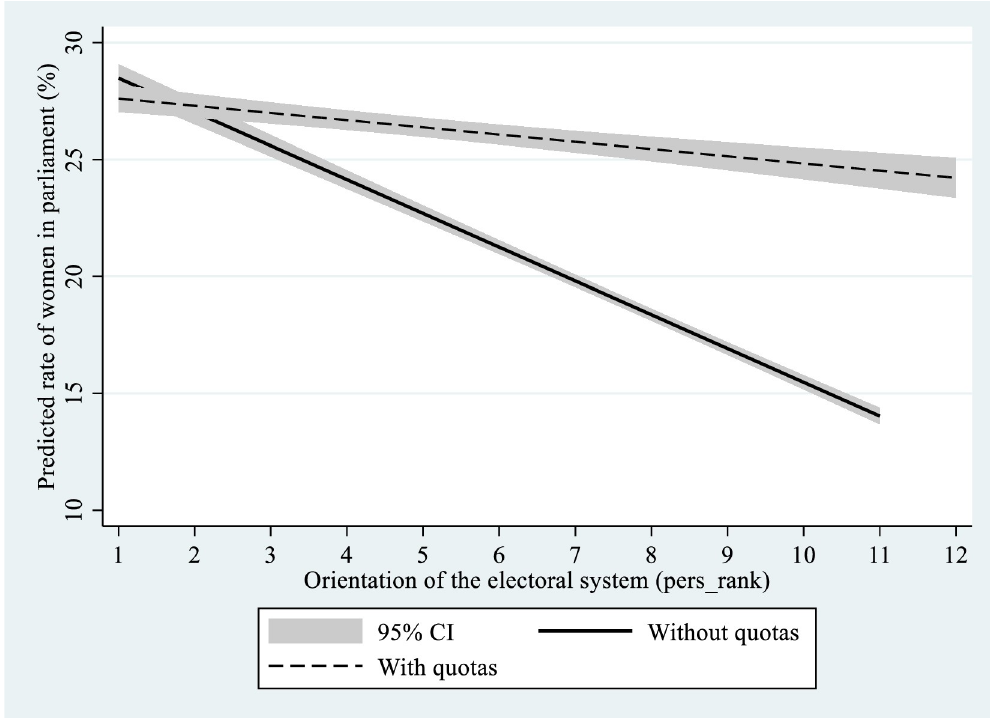
Fig 3. Women’s representation, by system orientation and